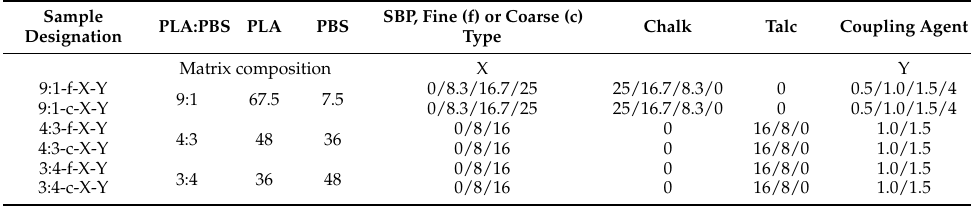
Table 1. Composition of the PLA–PBS–SBP composites in mass percent; “f” or “c” describes the type of SBP, fine or coarse, resp., “X” describes the amount of SBP in wt.% and “Y” the amount of coupling agent in wt.% added per 10% of SBP. The coupling agent amount was added additionally. Sum of PLA, PBS, SBP and mineral filler =